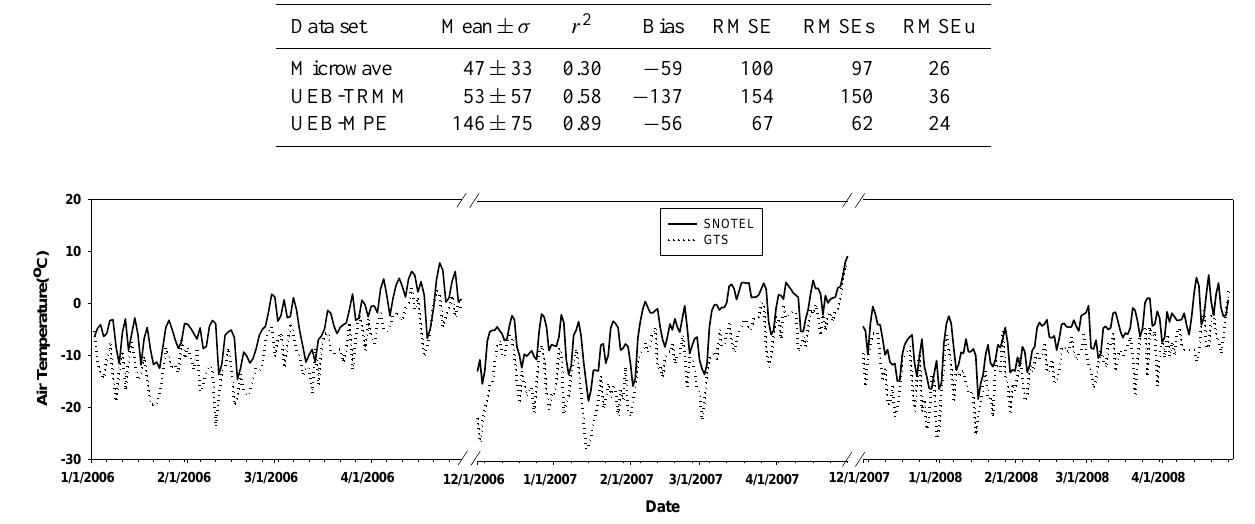
Fig. 3. Average daily forecasted GFS air temperature (dotted) and SNOTEL-recorded daily average temperature (solid line) at the 39 SNO- TEL sites. GFS’s air temperatures were extracted from 0.05 ◦ resolution grids and an average of the 06:00, 12:00, 18:00UTC, and the following day 00:00UTC forecasts.